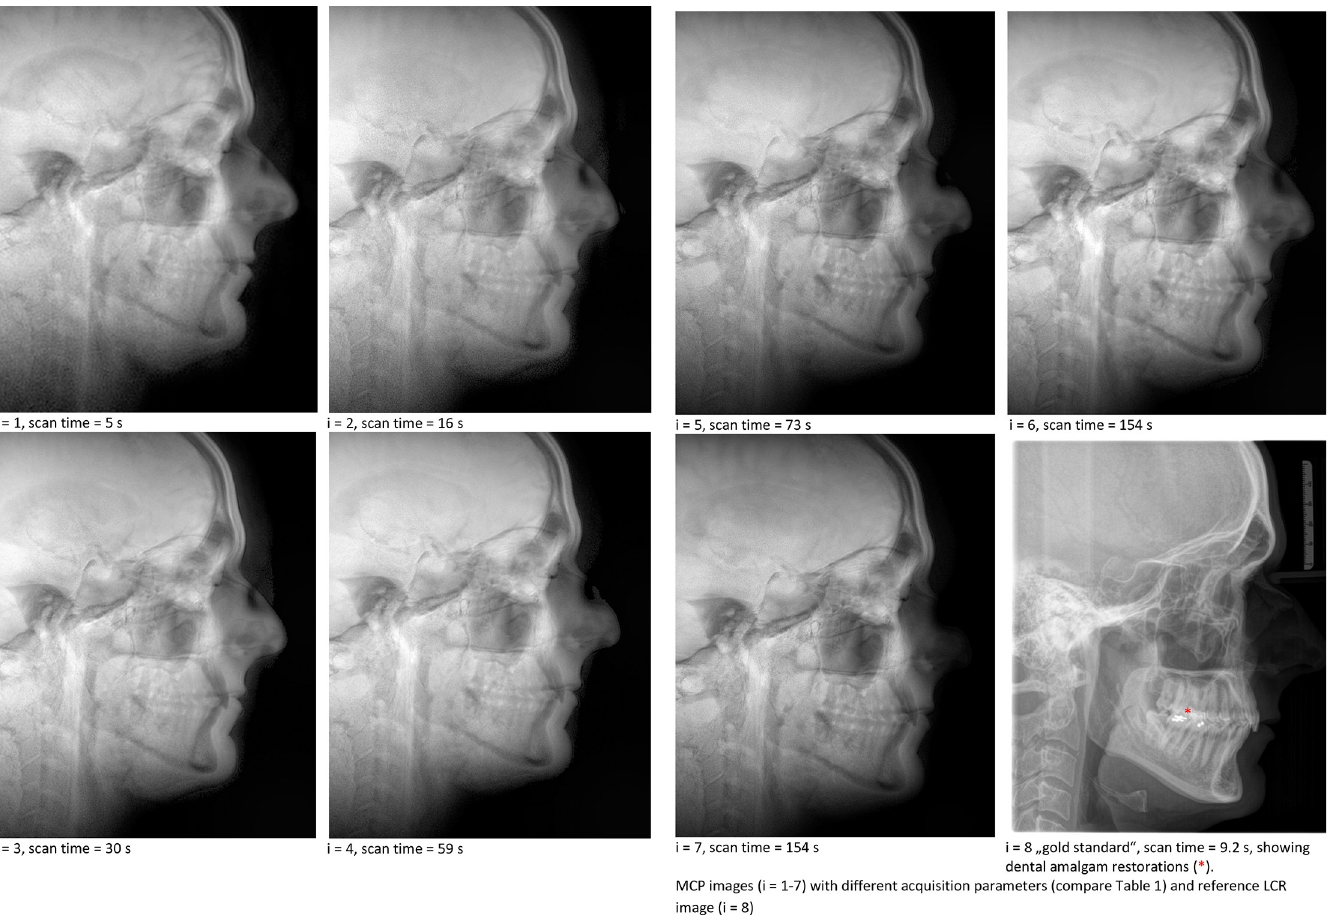
Fig 1. MCP images (i = 1–7) with different acquisition parameters (compare Table 1) and reference LCR image (i = 8).